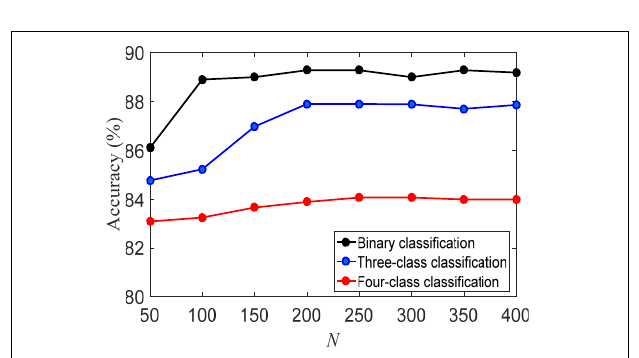
FIGURE 3 | Classification accuracy of local structure preservation sparse representation classifier (LMLS-SRC) under different training sets of each subclass.